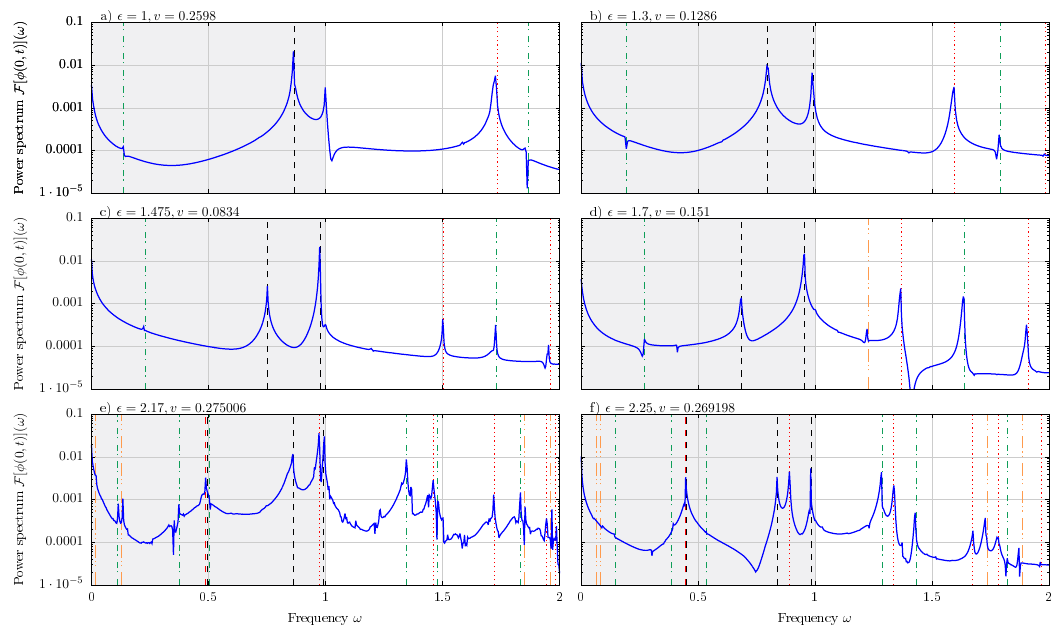
Figure 16 . Power spectra of fluctuations at the origin after a kink-antikink collision for various values of (cid:15) from 1 to 2 . 25 , showing signals of the extra internal kink modes which emerge as (cid:15) increases past 1 and then 2 . The speeds of the incident kink and antikink, shown above each subplot, is chosen in each case to be just larger than v c for that value of (cid:15) . Dashed black lines show the frequencies of the internal modes ω 1 , ω 2 and so on; red dotted lines are integer multiples of these frequencies; green dot-dashed lines are at | ω i ± ω j | , i 6 = j = 1 , 2 , 3 ; and orange dot-dashed lines at | 2 ω 1 ± ω i | , i = 2 , 3